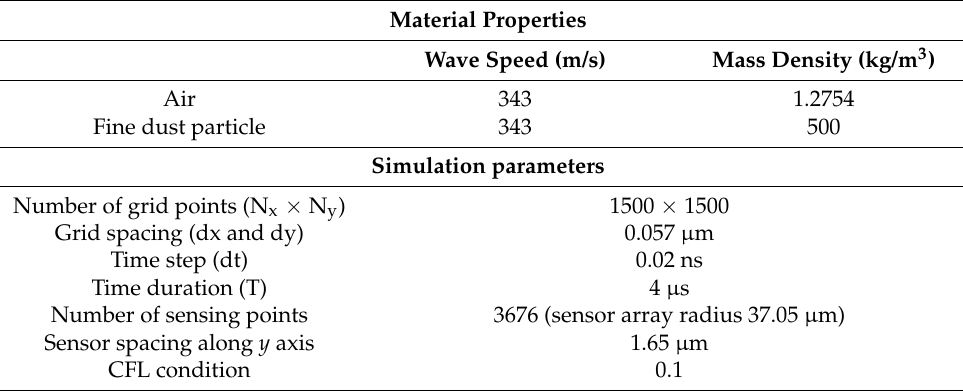
Figure 11. Analysis of scattering cross-section ( a ) particle shapes, ( b ) computed scattering cross-section. Table 1. Summary of numerical simulation